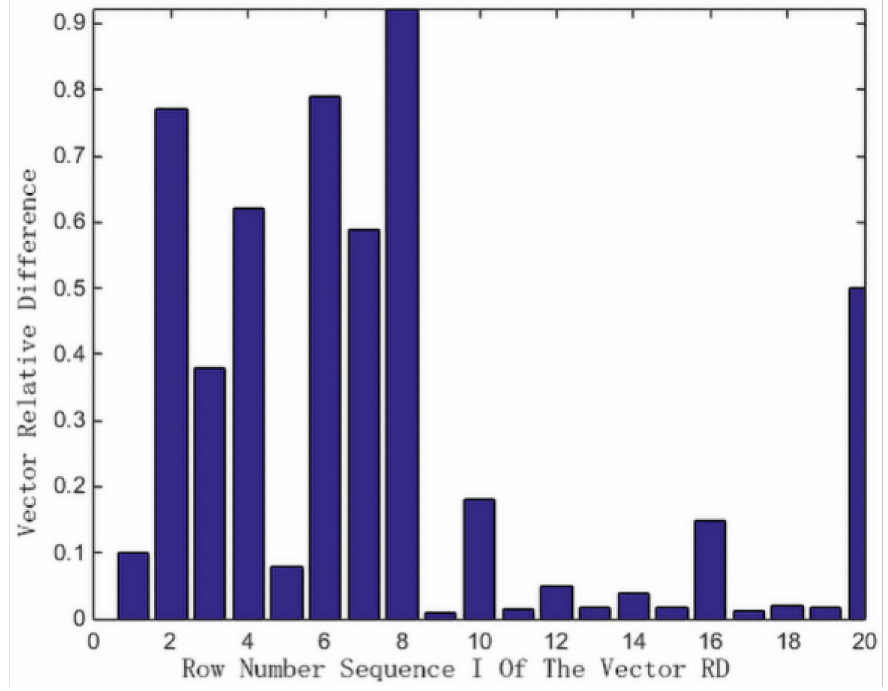
Figure 3. RD and RDI of signal { x (cid:48) }